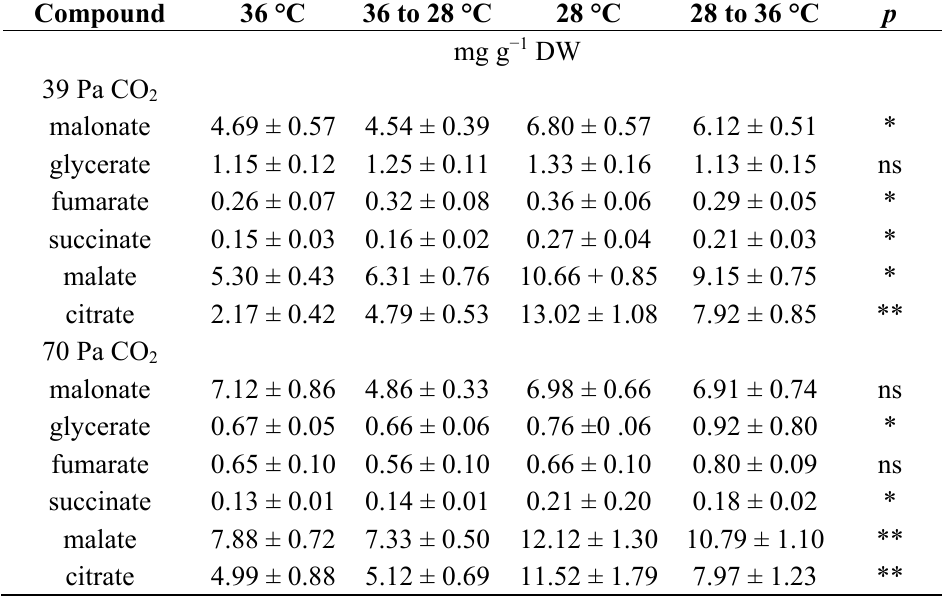
Table 1. Growth temperature treatment effects on organic acids in soybean leaflets. Values are means for data collected one, two and three days after reciprocal temperature shifts between ambient (28/20 °C) and above ambient (36/28 °C) growth temperatures. Probabilities were determined by ANOVA and are for * ( p ≤ 0.05), ** ( p ≤ 0.01) and ns, not